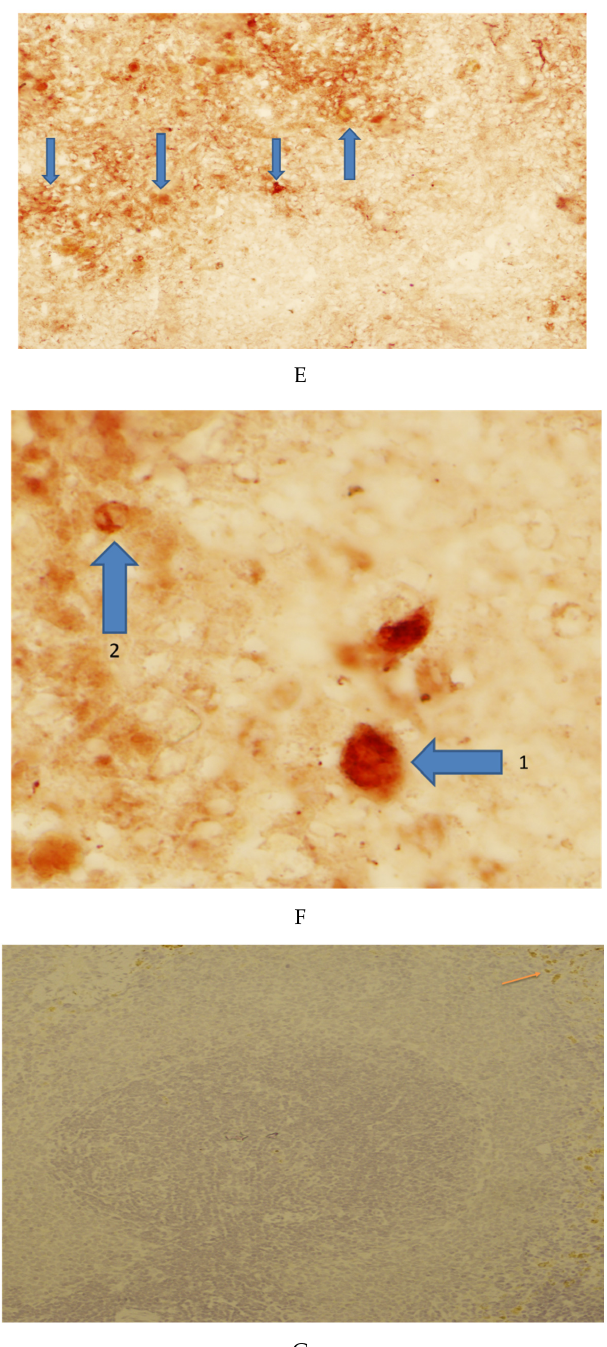
Figure 4. ( A ). Transgenic rat (TGR) spleen, original magnification 40×. gp120 immunostaining with brown DAB chromogen and counterstain with hematoxylin. Blue arrows point to several gp120-stained cells. ( B ) HIV-1TGR spleen, original magnification 10×. Negative control for gp120 immunostaining. Brown DAB chromogen and counterstain with hematoxylin. Orange arrow points to hemosiderin, not a DAB label. ( C ) TAT immunostaining of the HIV-1TGR spleen. Original